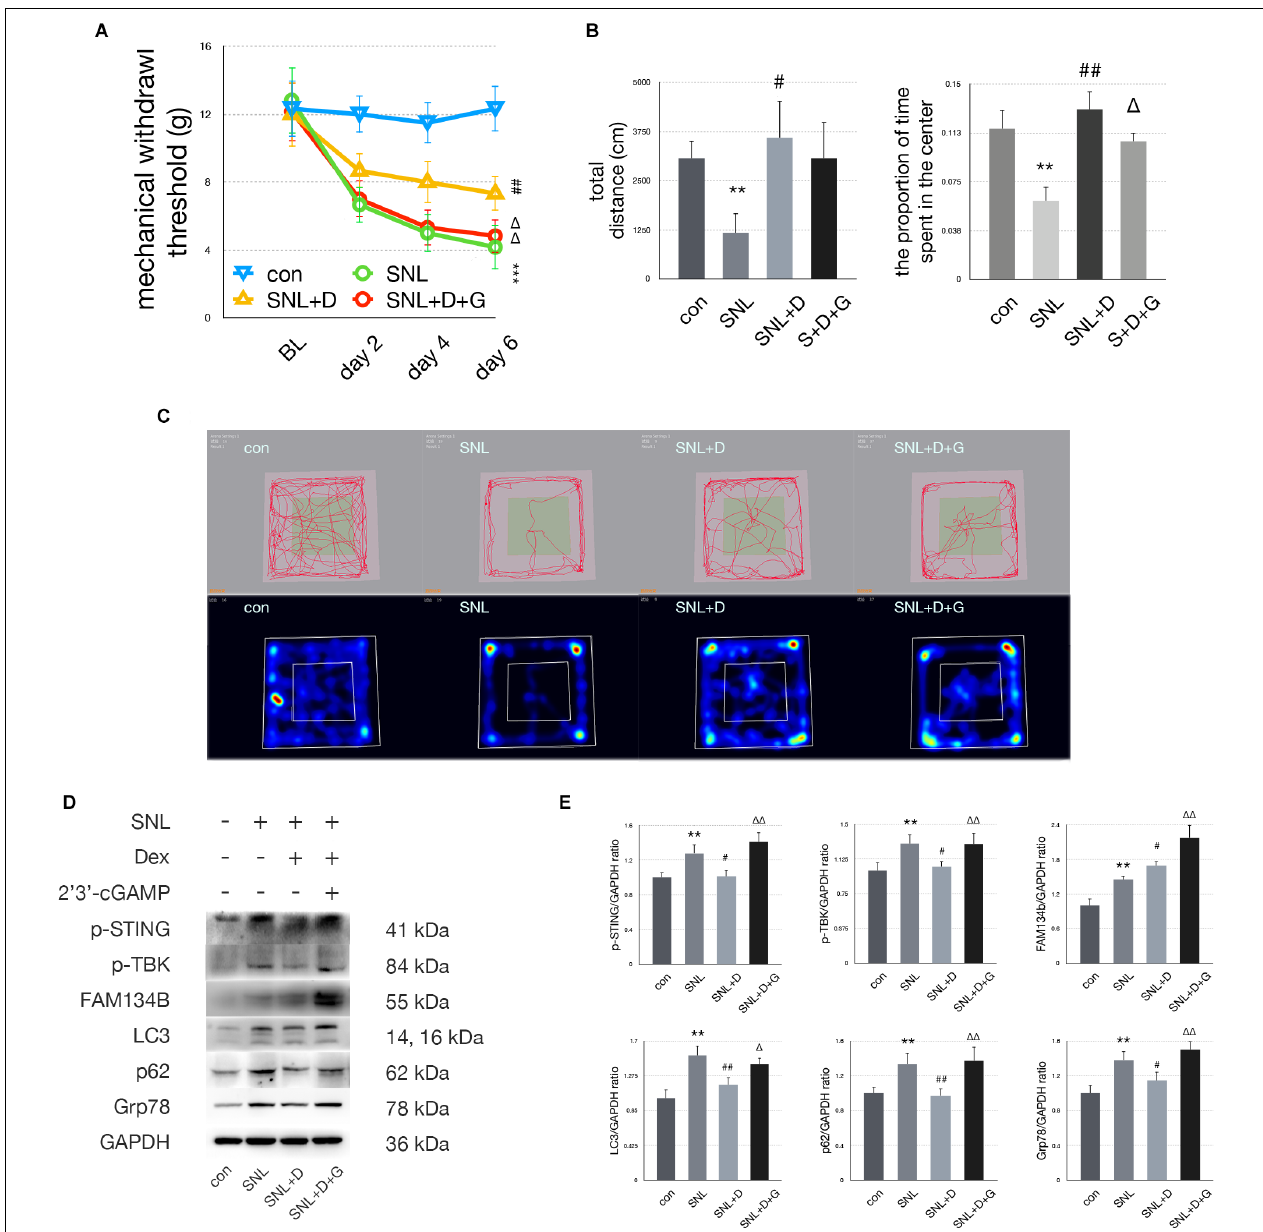
FIGURE 5 | Dexmedetomidine provided anti-anxiety effects by inhibiting the STING/TBK pathway. (A) MWT tests of control, SNL, SNL+D, and SNL+D+G groups (two-way ANOVA). (B) Quantification of open field of control, SNL, SNL+D, and SNL+D+G groups (one-way ANOVA, total distance: F = 13.260, P = 0.003; proportion of time spent in the center: F = 16.520, P = 0.006). (C) Trace map and heat map of control, SNL, SNL+D, and SNL+D+G groups. (D) Western blot of control, SNL, SNL+D, and SNL+D+G groups. (E) Western blot quantification of control, SNL, SNL+D, and SNL+D+G groups (one-way ANOVA, p-STING/GAPDH: F = 6.092, P = 0.006; p-TBK/GAPDH: F = 3.709, P = 0.034; FAM134b/GAPDH: F = 13.979, P = 0.007; LC3/GAPDH: F = 9.265, P = 0.001; p62/GAPDH: F = 4.268, P = 0.022; Grp78/GAPDH: F = 8.613, P = 0.001). N = 6 rats per group, * P < 0.05 compared with control; ** P < 0.01 compared with control group; *** P < 0.001 compared with control group; # P < 0.05 compared with SNL; ## P < 0.01 compared with SNL group; ∆ P < 0.05 compared with SNL+D; ∆∆ P < 0.01 compared with SNL+D. Abbreviations: BL, baseline; Dex, dexmedetomidine; control group, rats received a sham operation and vehicle; SNL group, rats received